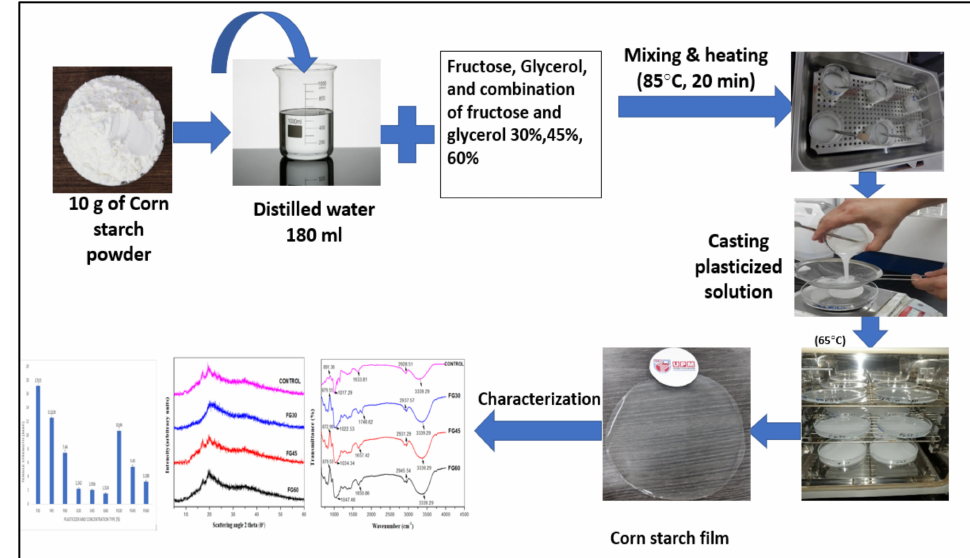
Figure 1. Flow chart of film